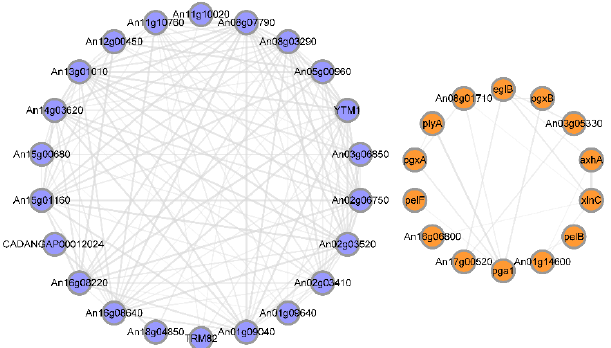
Figure 7. Protein-protein interaction (PPI) network of the 36 representative DEGs. Colored nodes represent query proteins and first shell of interactors. Edges represent protein – protein associations.